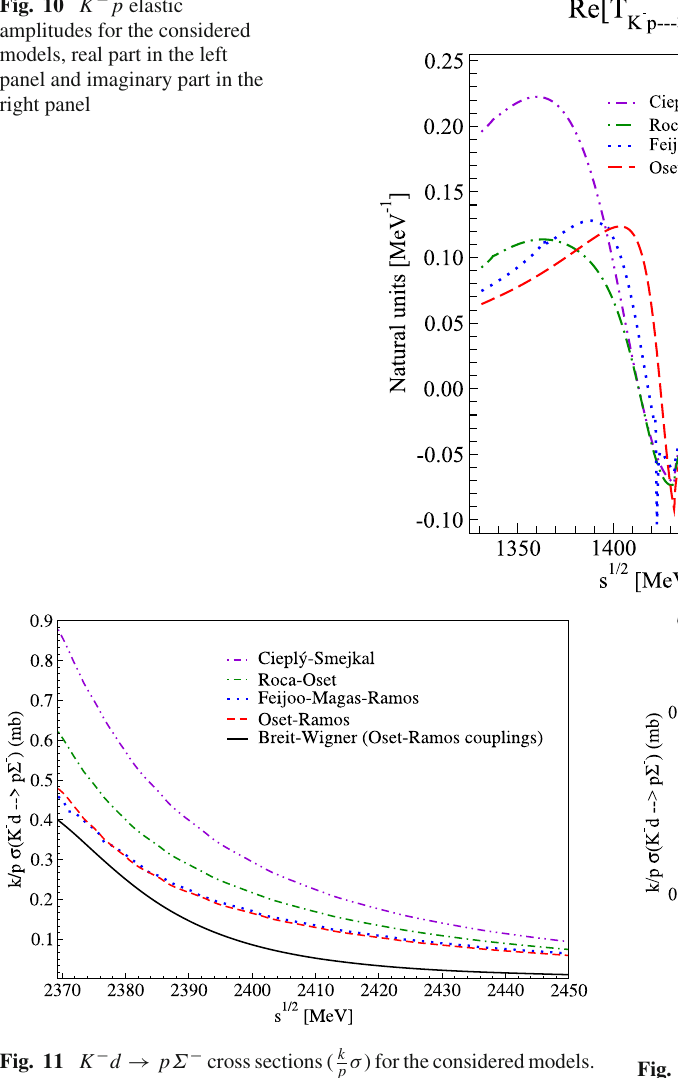
Fig. 10 K − p elastic amplitudes for the considered models, real part in the left panel and imaginary part in the right panel